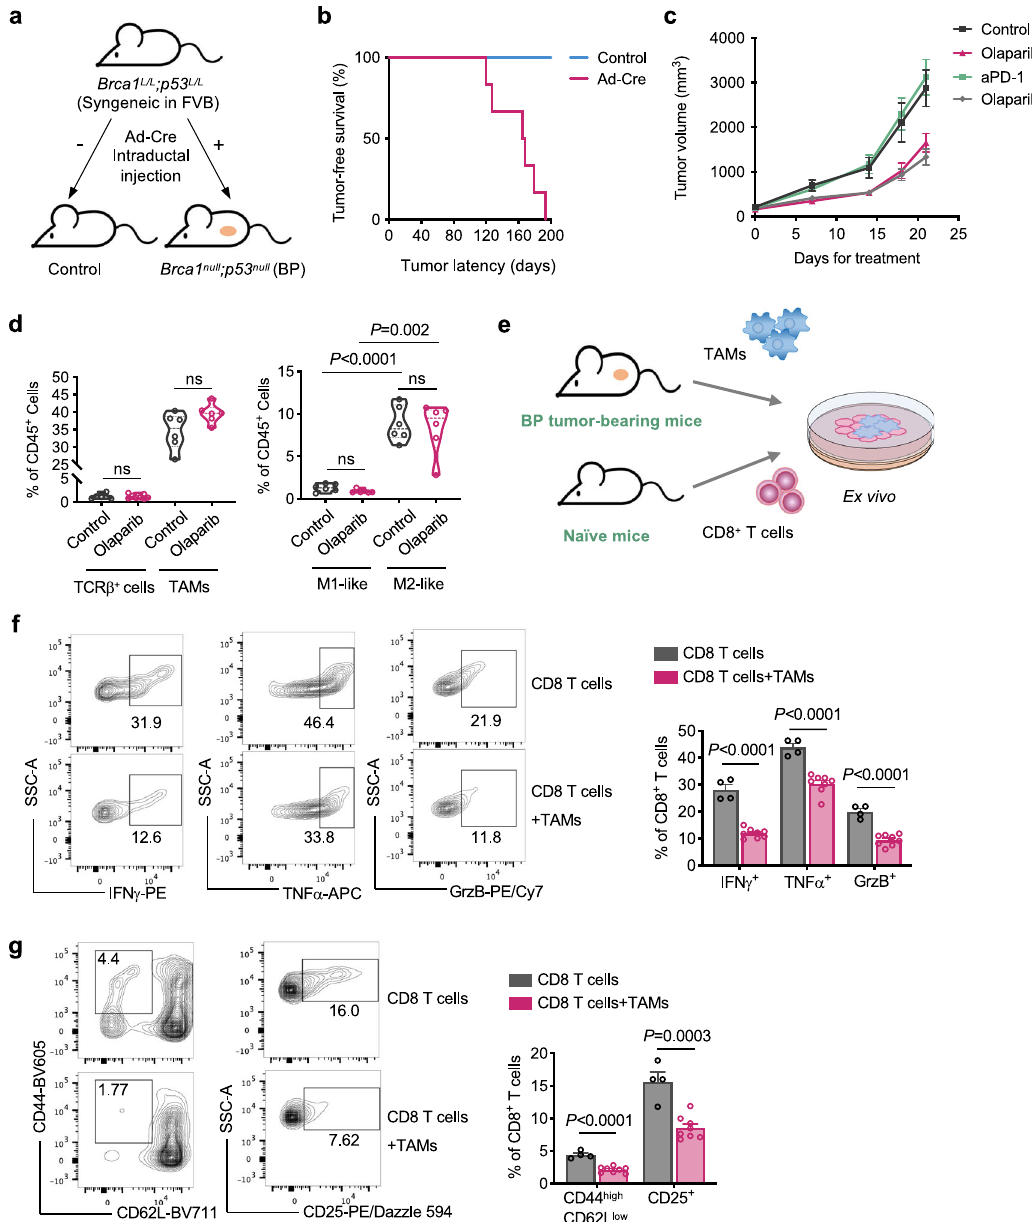
Fig. 1 Brca1 -de fi cient breast tumors have a modest response to olaparib in vivo with immune-suppressive TAMs. a Generation of a syngeneic GEMM of Brca1 -de fi cient breast tumors by intraductal injection of adenovirus expressing Cre recombinase (Ad-Cre) directly into the lumen of mammary glands. b Tumor-free survival of Brca1 L/L Trp53 L/L mice with or without intraductal injection of Ad-Cre ( n = 6). c Tumor growth of Brca1 − / − Trp53 − / − (BP) allografts in FVB mice treated with olaparib or anti-PD-1 as monotherapy or in combination. Control, n = 8; anti-PD-1, n = 8; olaparib, n = 6; olaparib + anti-PD-1, n = 10. d Flow cytometry analysis of TCR β + T cells and tumor-associated macrophages (TAMs; CD45 + CD11b + F4/80 + ) from BP tumors in FVB mice after 21 days of olaparib treatment. TCR β + (control), n = 6; TCR β + (olaparib), n = 8; TAMs (control), n = 6; TAMs (olaparib), n = 6. TAMs were further analyzed to identify M1-like (MHC-II high CD206 − ) and M2-like (MHC-II low CD206 + ) polarization phenotypes ( n = 6 for each group). Each dot represents data from a single tumor. e Diagram of work fl ow for ( f ) and ( g ). TAMs (7AAD − CD45 + CD11b + F4/80 + ) were sorted from BP breast tumors and co-cultured with splenic CD8 + T cells isolated from naïve mice for 2 days. f Analysis of cytokine production by CD8 + T cells co-cultured with TAMs (CD8 + T cells, n = 4; CD8 + T cells + TAMs, n = 8). g Analysis of the proportion of effector cells (CD44 high CD62L low ) and surface expression of CD25 of CD8 + T cells co-cultured with TAMs (CD8 + T cells, n = 4; CD8 + T cells + TAMs, n = 8). Flow cytometry plot axes are displayed in logarithmic scale ( f ) and ( g ). Data are presented as mean ± SEM ( c ), ( f ), and ( g ), or median with quartiles (violin plots, d ). Two-way analysis of variance (ANOVA) ( c ). Two-tailed unpaired t test or Mann – Whitney test ( d ), ( f ), and ( g ). ns not signi fi cant. Source data are provided as a Source Data fi le.